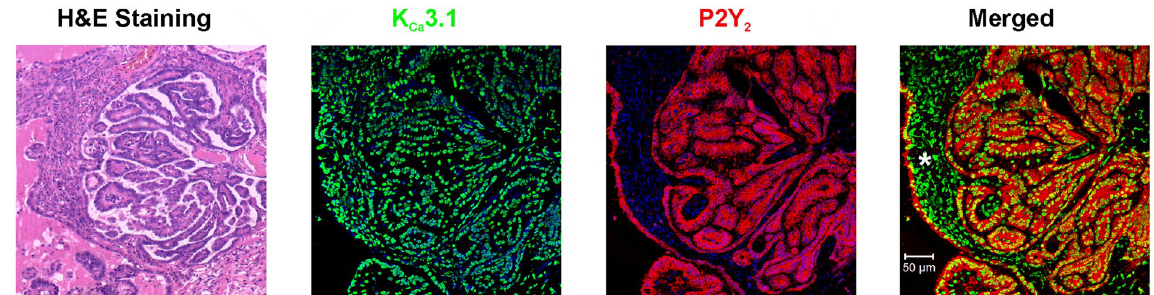
Figure 8. Co-localization of P2Y 2 receptor and K Ca 3.1 channel in human ovarian carcinoma. Expression of P2Y 2 receptors and K Ca 3.1 channels in slices from human ovarian carcinoma evaluated immunohistochemically. Biopsies from ovarian carcinoma tissue were collected, processed, and stained with hematoxylin-eosin and/ or labeled with K Ca 3.1- and P2Y 2 -specific antibodies that were revealed by second antibodies coupled to green and red fluorescent dyes, respectively. Nuclei in blue labeled with DAPI. Positive co-expression was detected in ovarian neoplastic cells (see merged image), whereas no signal was observed in control assays in which the primary antibody was omitted. Expression of K Ca 3.1 was also observed in stromal cells that did not show neoplastic morphology ( * ); however, P2Y 2 did not co-localize with K Ca 3.1 in these cells. Patient 1,